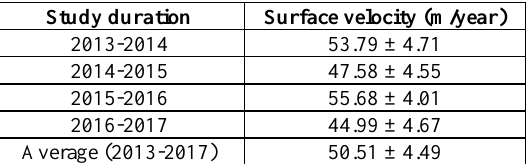
Table 3. Annual surface